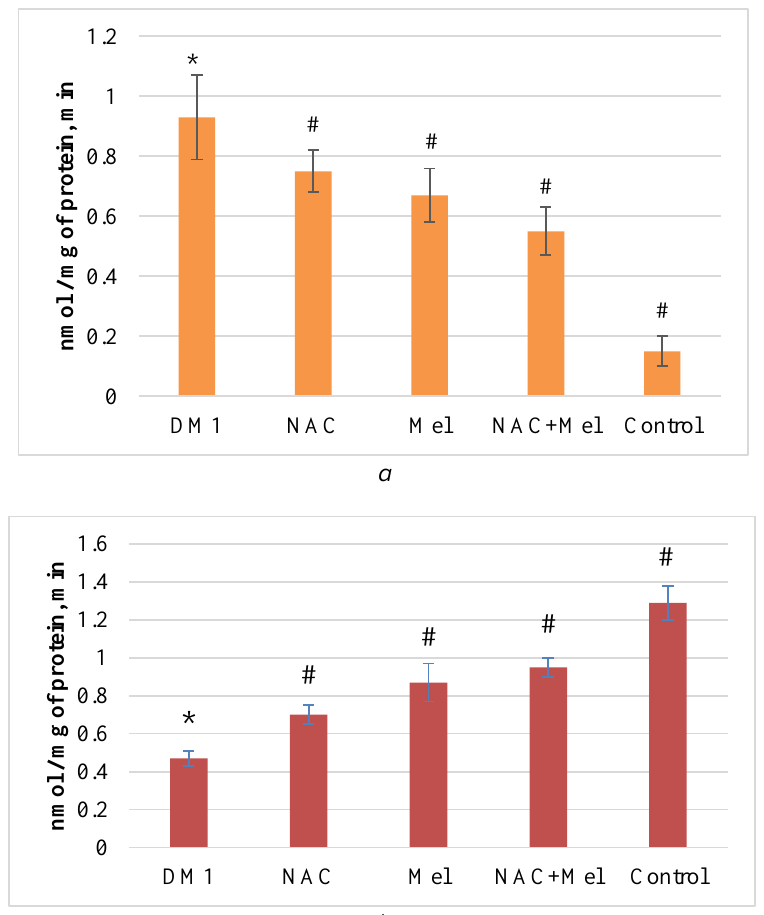
Fig. 1. Influence of N-acetylcysteine (NAC) and melatonin (Mel) on the rate of generation of superoxide radicals and nNOS activity in mitochondria of brain cells: a – the rate of generation of superoxide radicals; b – nNOS activity. DM 1 (rats with diabetes mellitus 1 receiving physiological saline per os); NAC (rats with DM 1, administered NAC at a dose of 1.5 g / kg per os); Mel (rats with DM 1 receiving Mel in a dose of 10 mg / kg per os); NAC+Mel (diabetic rats receiving NAC and Mel per os combination therapy); control (intact rats). NAC / Mel or NAC+Mel was administered within 5 weeks. * in comparison with control, p <0.05; # in comparison with DM 1, p<0.05